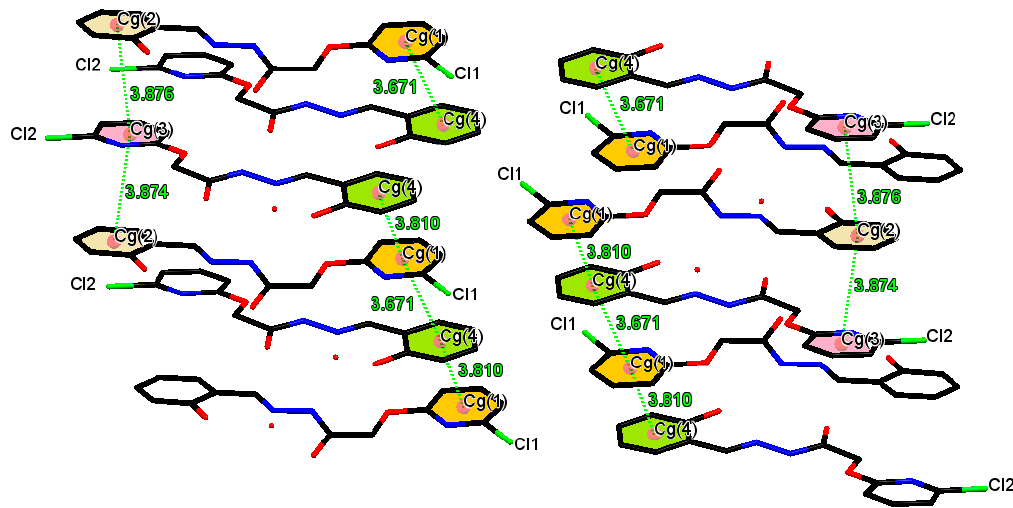
7 of 20 Figure 4. Packing diagram of HBPAH showing H-bonded connection of first, 2nd type of molecules and water with H-atoms not engaged in H-bonding are omitted for clearness. Red color shows oxygens, blue nitrogen, green chlorine, and black/white contours shows carbon atoms. Table 2. Geometrical parameters of potential Hydrogen-bonds (Å, º) for HBPAH. D—H···A